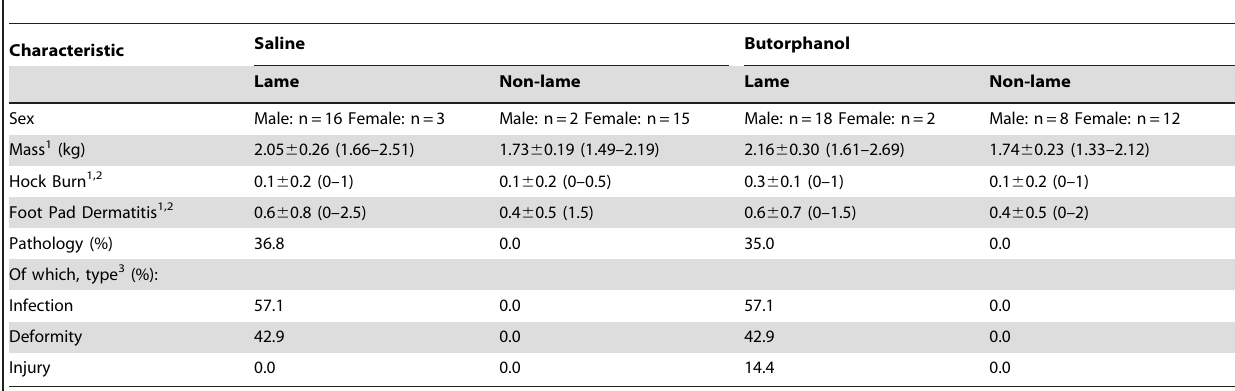
Table 3. Key sample characteristics for birds administered butorphanol or saline (n=76).